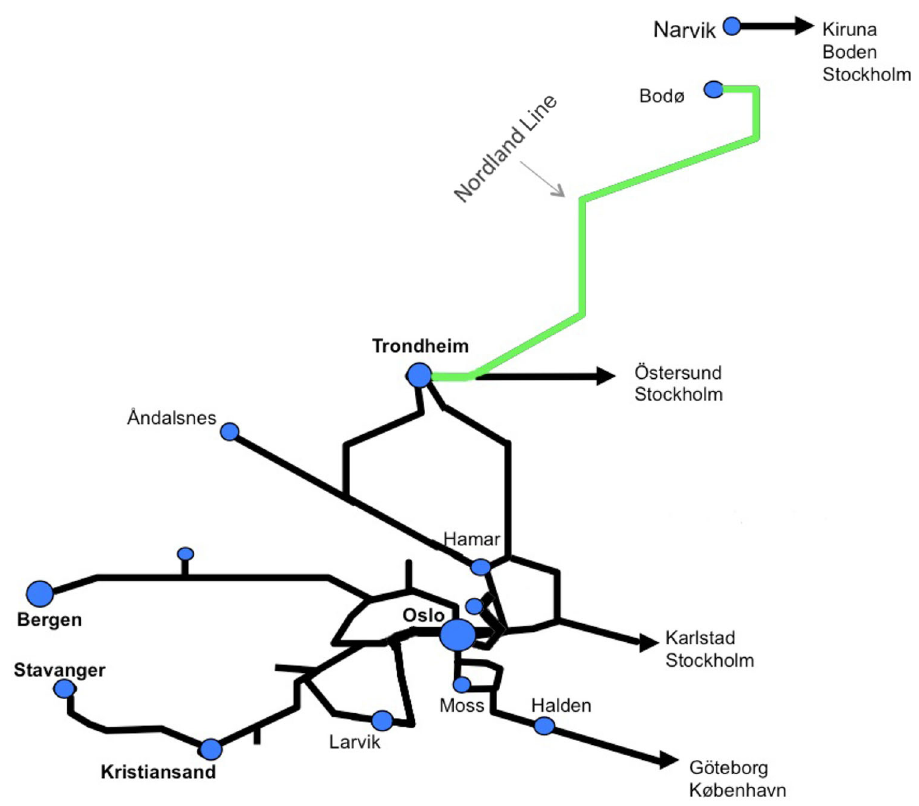
Fig. 1 Norwegian railway